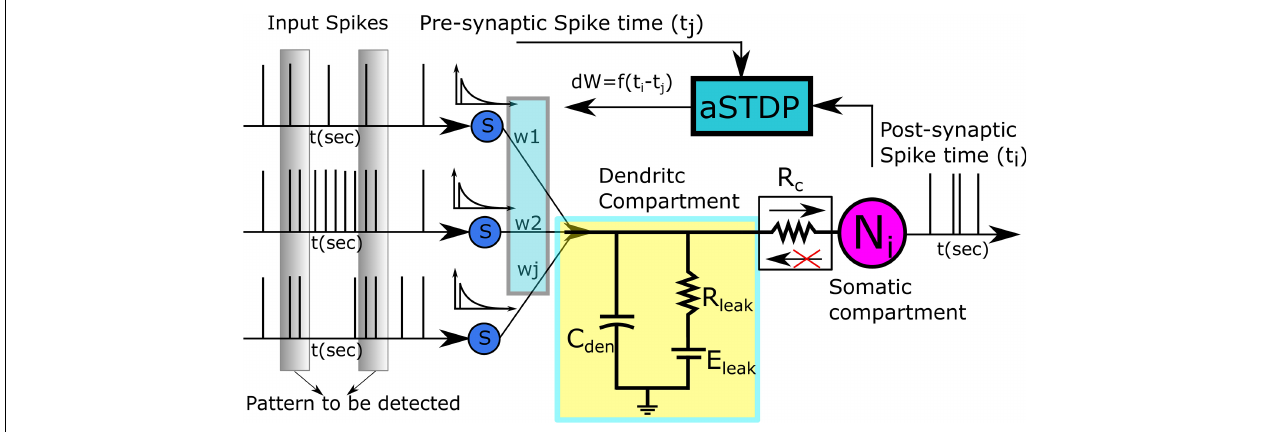
FIGURE 2 | Pattern Recognition Setup. The dendritic compartment is passive and is represented by a dendritic capacitance C den , and a leak resistor R leak . The Adaptive STDP modifies the value of synaptic weights based on the time of the pre- and the postsynaptic